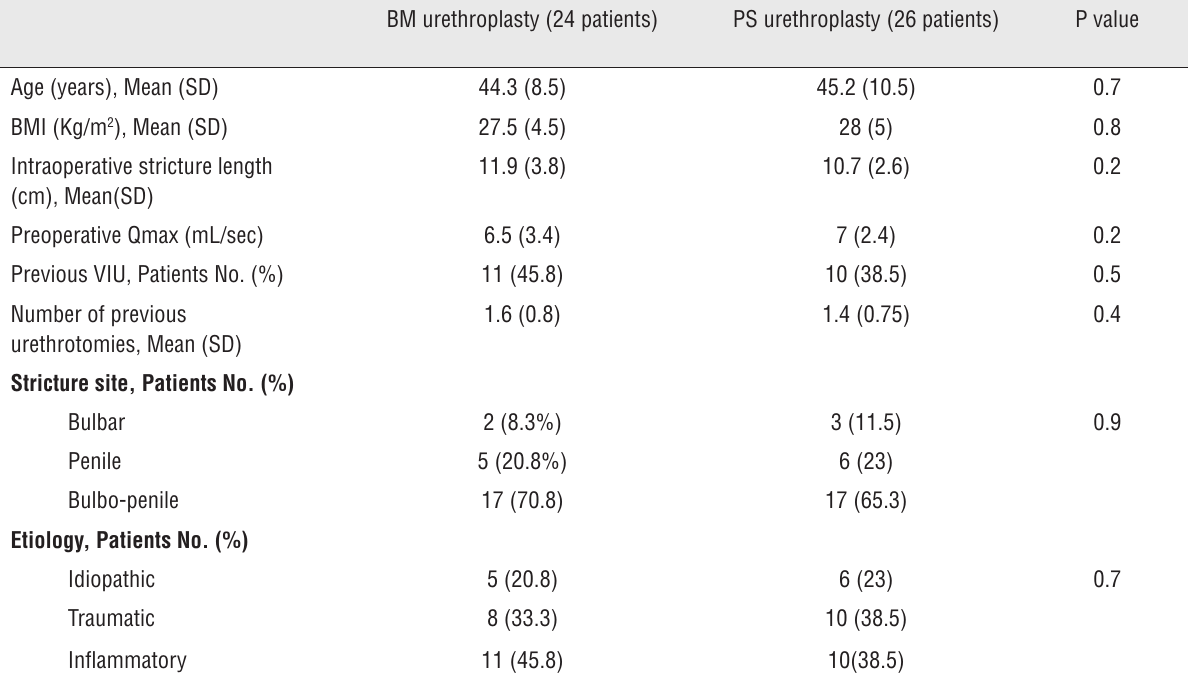
Table 1 - Pre-operative patient’s characteristics. BM urethroplasty (24 patients) PS urethroplasty (26